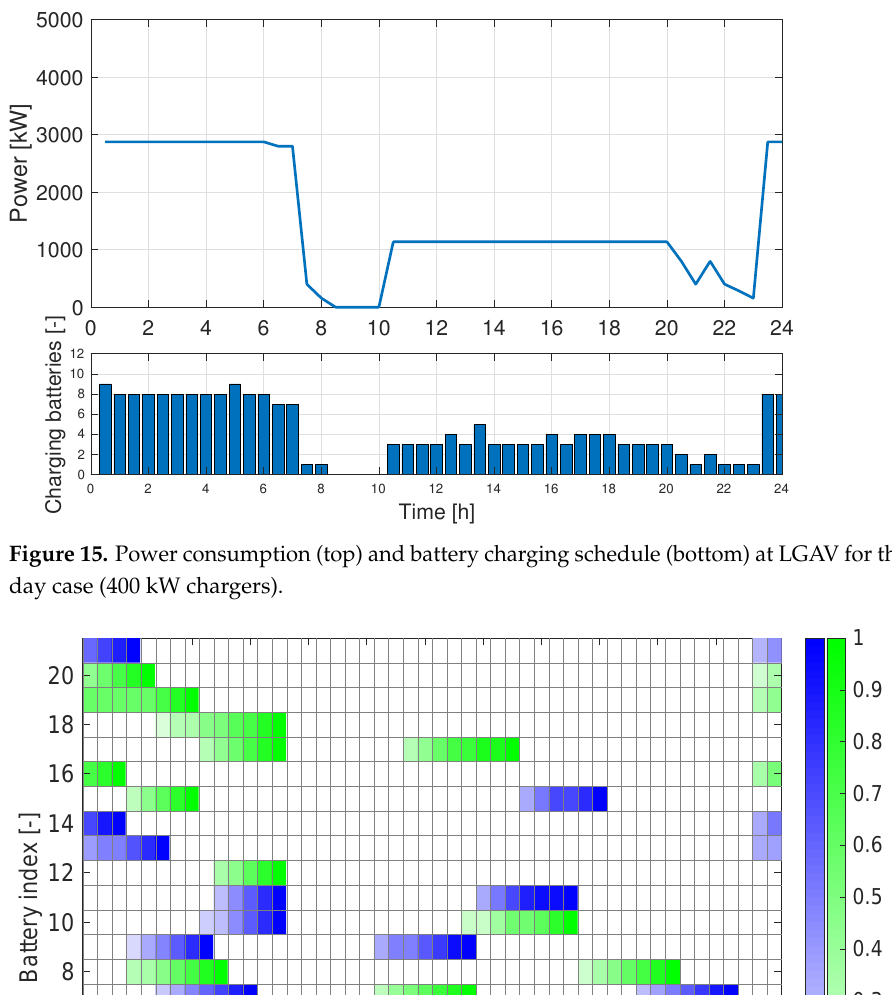
Figure 14. Energy expenditure at LGAV for the average day case (400 kW chargers).